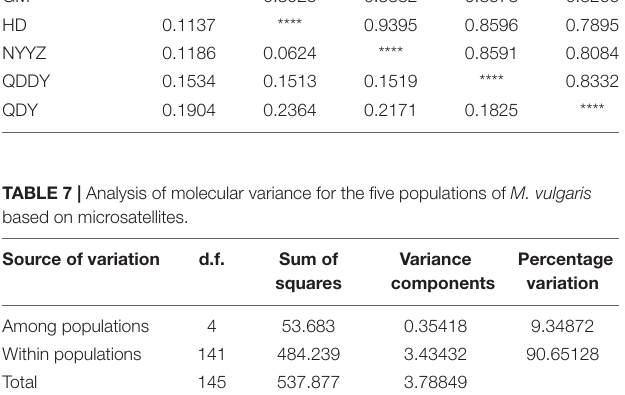
TABLE 6 | Nei’s genetic identity (above diagonal) and genetic distance (below diagonal) of the five populations of M. vulgaris based on microsatellites. Population ID GM HD NYYZ